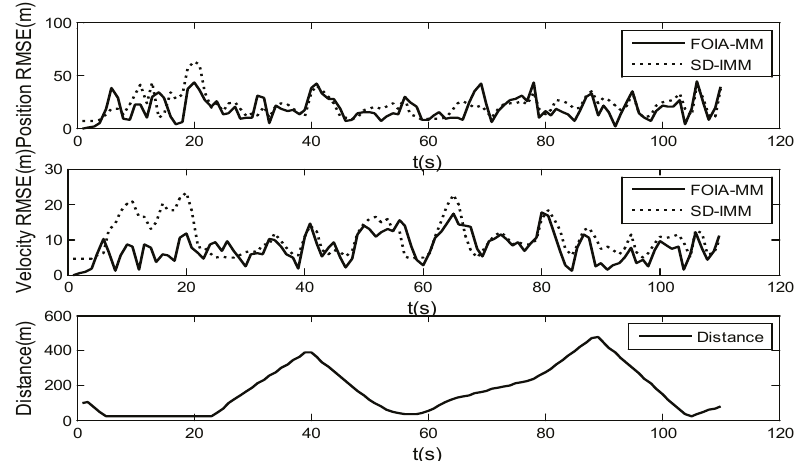
Figure 11. Root-mean-square error (RMSE) of position (m) and velocity (m/s); ( σ 1 = 30 m ), distance between the true position and the obstacle areas.